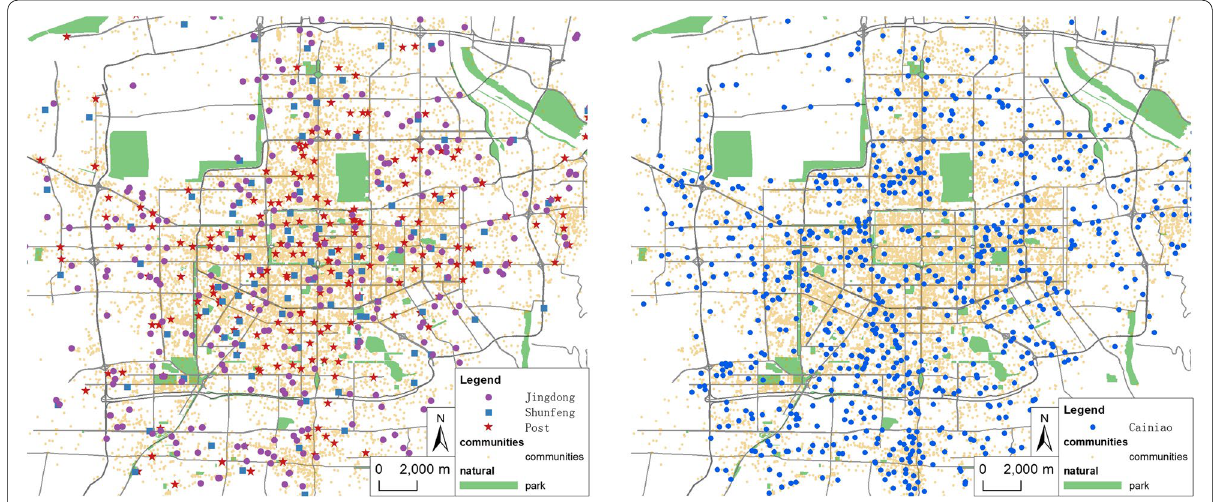
Fig. 4 The network layout for Post, Shunfeng, Jingdong and Cainiao in